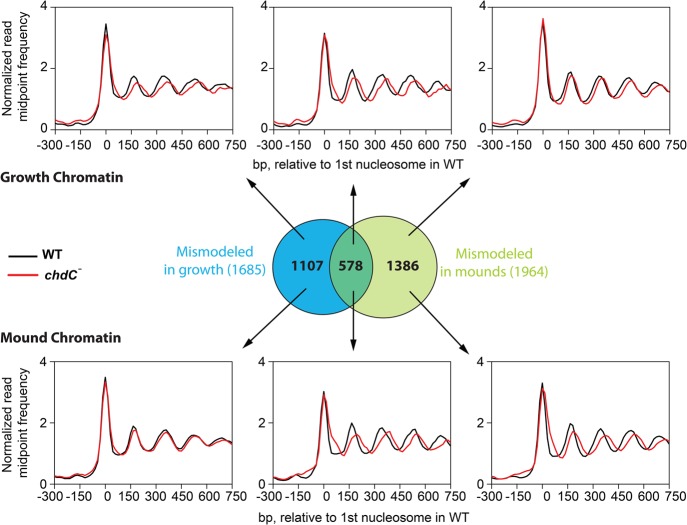
Genes are mismodeled at multiple stages of the chdC-null life cycle. Venn diagram indicates significant (P < 2 × 10−16) overlap among genes that are mismodeled in both growing-stage and loose-mound–stage chdC-null cells; P-value was calculated using the hypergeometric test. (Top) When the different mismodeled gene sets are analyzed for paired read midpoint frequency distributions in growing WT (black) or chdC-null (red) cells, only genes that are mismodeled in growing cells exhibit an increased NRL in growing cells; genes that are characterized as only mismodeled in loose-mound–stage cells do not exhibit this increased NRL in growing cells. (Bottom) When the different mismodeled gene sets are analyzed for paired read midpoint frequency distributions in loose-mound–stage WT (black) or chdC-null (red) cells, only genes that are mismodeled in loose-mound–stage cells exhibit an increased NRL in loose-mound–stage cells; genes that are characterized as only mismodeled in growing cells do not exhibit this increased NRL in loose-mound–stage cells.